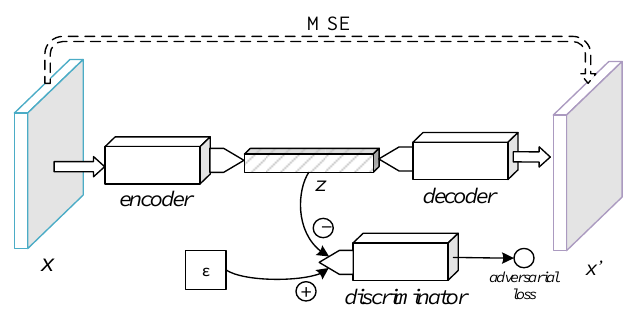
Figure 4. Diagram of the adversarial